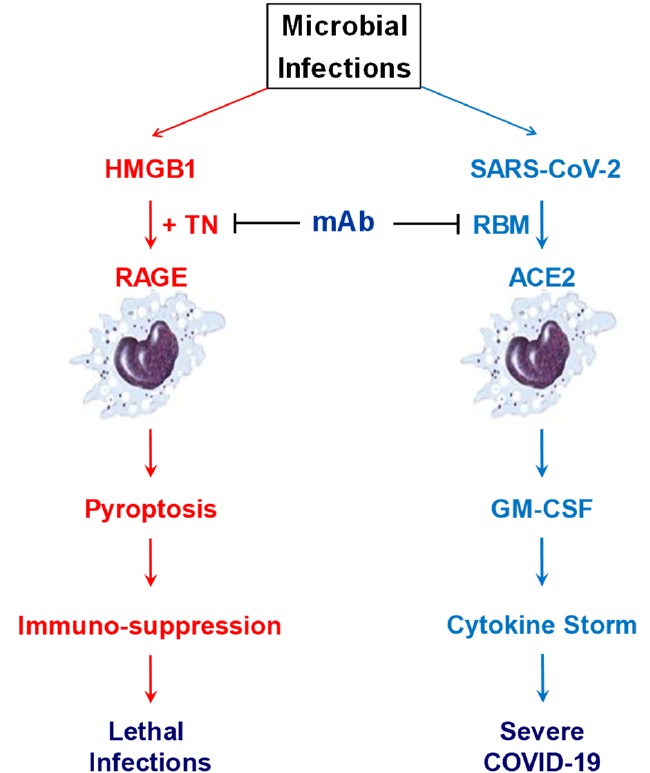
Figure 5. Potential therapeutic effects of cross-reactive monoclonal antibodies against TN and RBM of SARS-CoV-2. Some TN domain (NDALYEYLRQ)-specific mAbs may confer protection against lethal infections partly by preventing harmful TN/HMGB1 interaction that may adversely trigger macrophage pyroptosis and immunosuppression. Some TN-reactive mAbs also cross-reacted with a tyrosine (Y)-rich segment (YNYLYR) in the RBM of SARS-CoV-2, and specifically inhibited RBM-induced production of GM-CSF, a biomarker and mediator of COVID-19. The dual effects of these cross-reactive mAbs in attenuating immuno-suppression and SARS-CoV-2-induced GM-CSF production make them promising therapeutic candidates for treating COVID-19 and other lethal